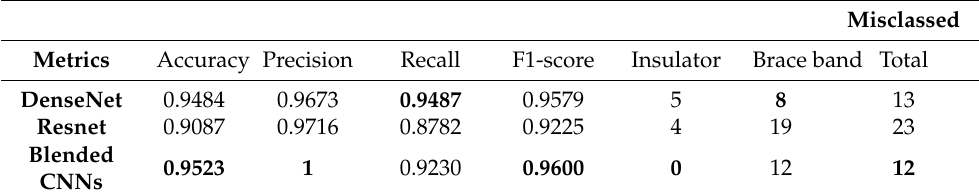
Figure 25. Confusion matrix of blended pipelines. Table 2. Comparison of single CNN and Blend results.